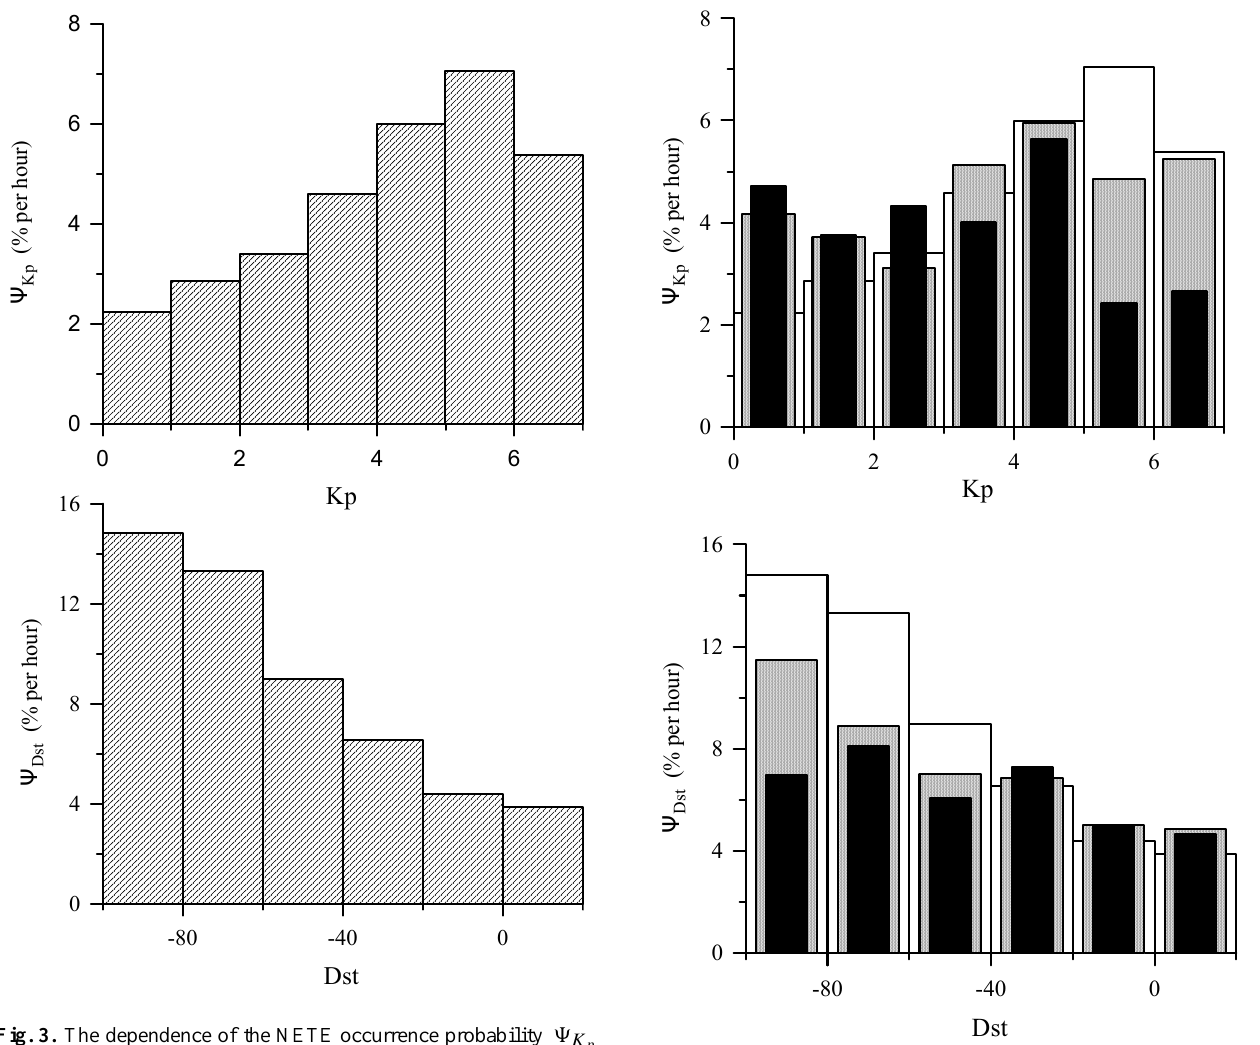
p and 9 D on current (white bins) and previous (gray and black bins) st values of 3-h geomagnetic index K p (top panel) and 1-h index D st (bottom panel). For both indices, the histograms with gray bins show the probability versus the indices measured 9h before the NETEs peaks, while the black bins correspond to the results ob- tained with the indices measured 15h before